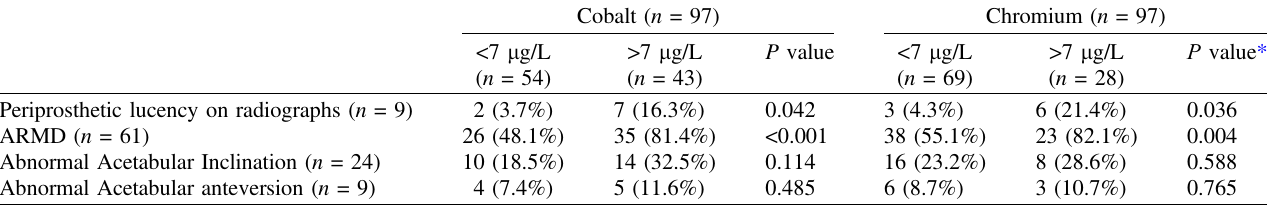
Table 2. Association of blood chromium and cobalt levels with imaging fi ndings.